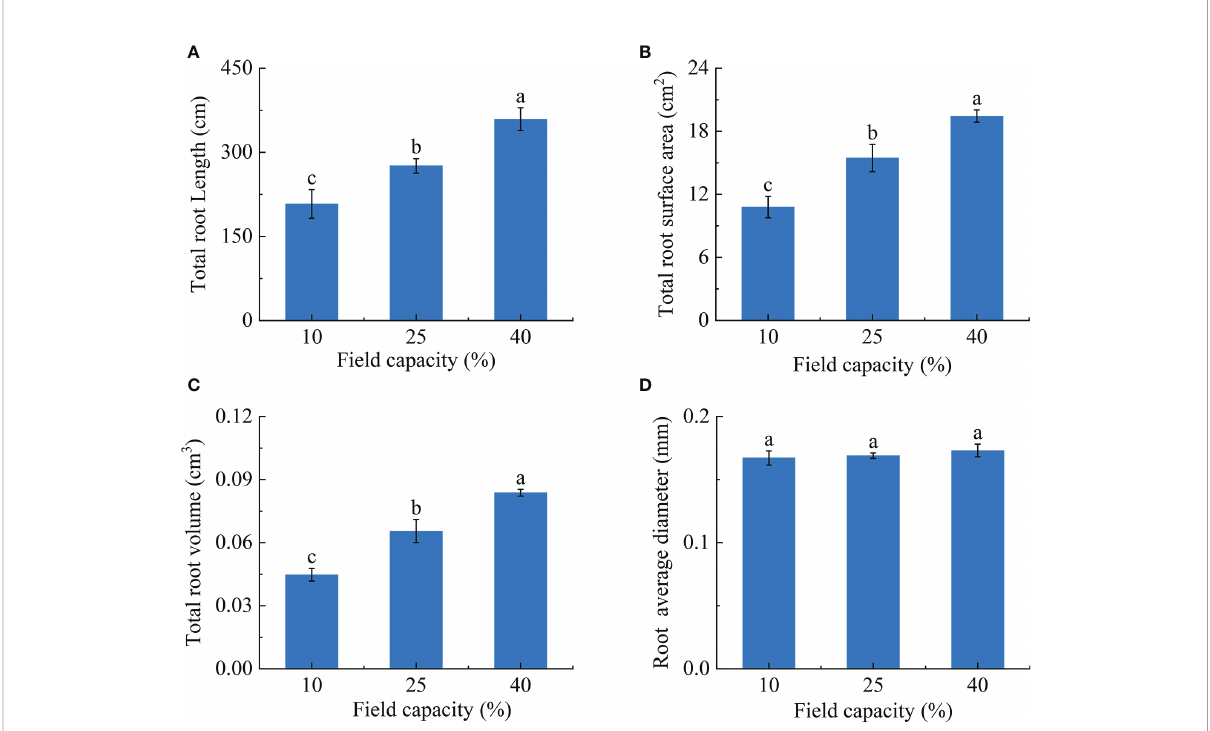
FIGURE 2 Effects of different soil moisture on total root length (A) , total root surface area (B) , total root volume (C) and average root diameter (D) of K hirsuta . Results were analyzed by one-way ANOVA and tested for signi fi cance of difference by Duncan multiple-range method. Each value represents the mean ± standard error. Each experiment was repeated four times. Different letters indicate that the differences between treatments were signi fi cant ( P <